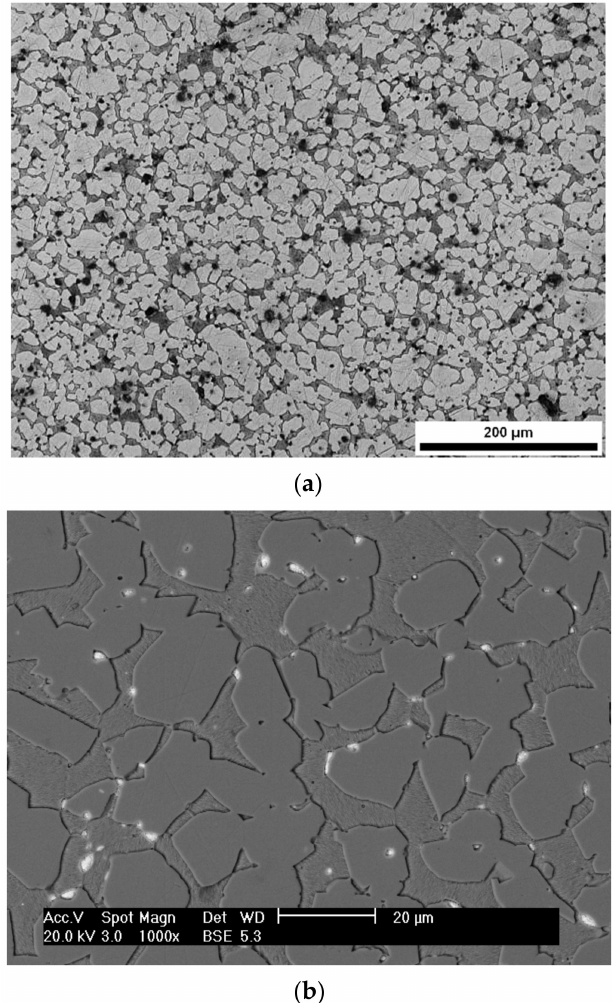
Figure 1. ( a ) Optical micrograph and ( b ) SEM micrograph showing the typical microstructure of CuZn39Pb3 (CW614N) brass